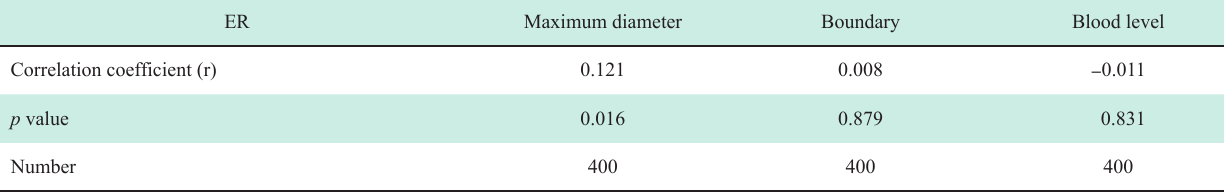
Table3 Correlation between tumor maximum diameter, tumor boundary, blood flow signal classification and